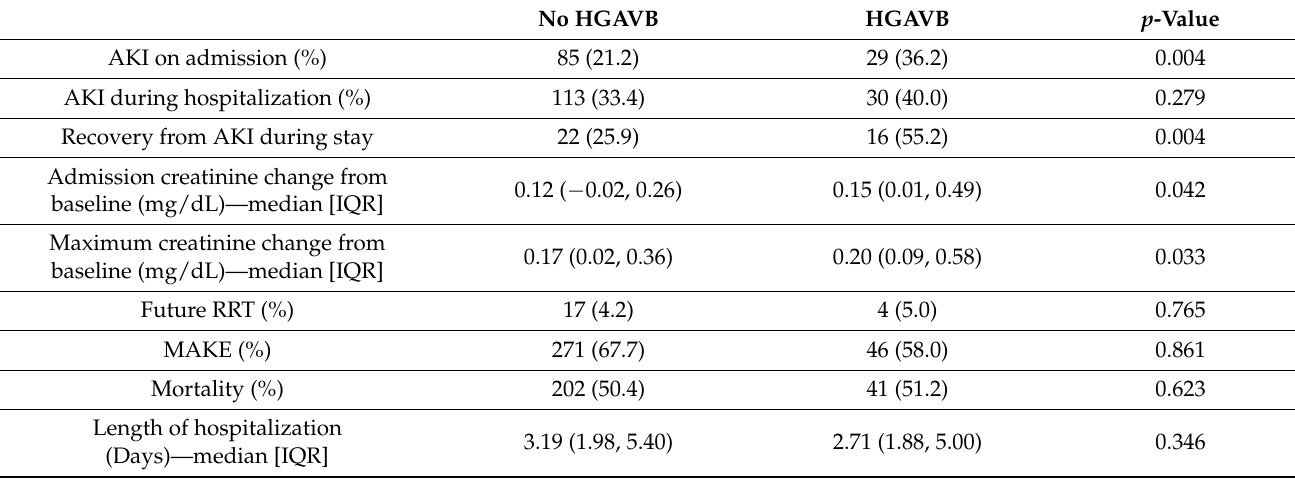
Table 3. Primary and secondary endpoints of patients with and without high grade AV block